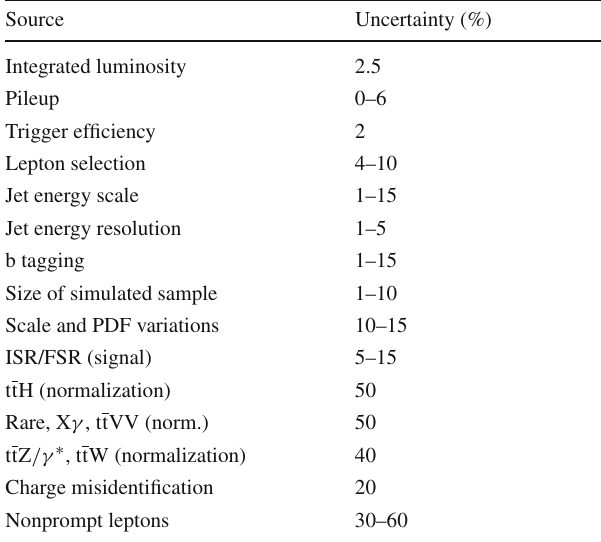
Table 3 Summary of the sources of uncertainty and their effect on sig- nal and background yields. The first group lists experimental and theo- retical uncertainties in simulated signal and background processes. The second group lists normalization uncertainties in the estimated